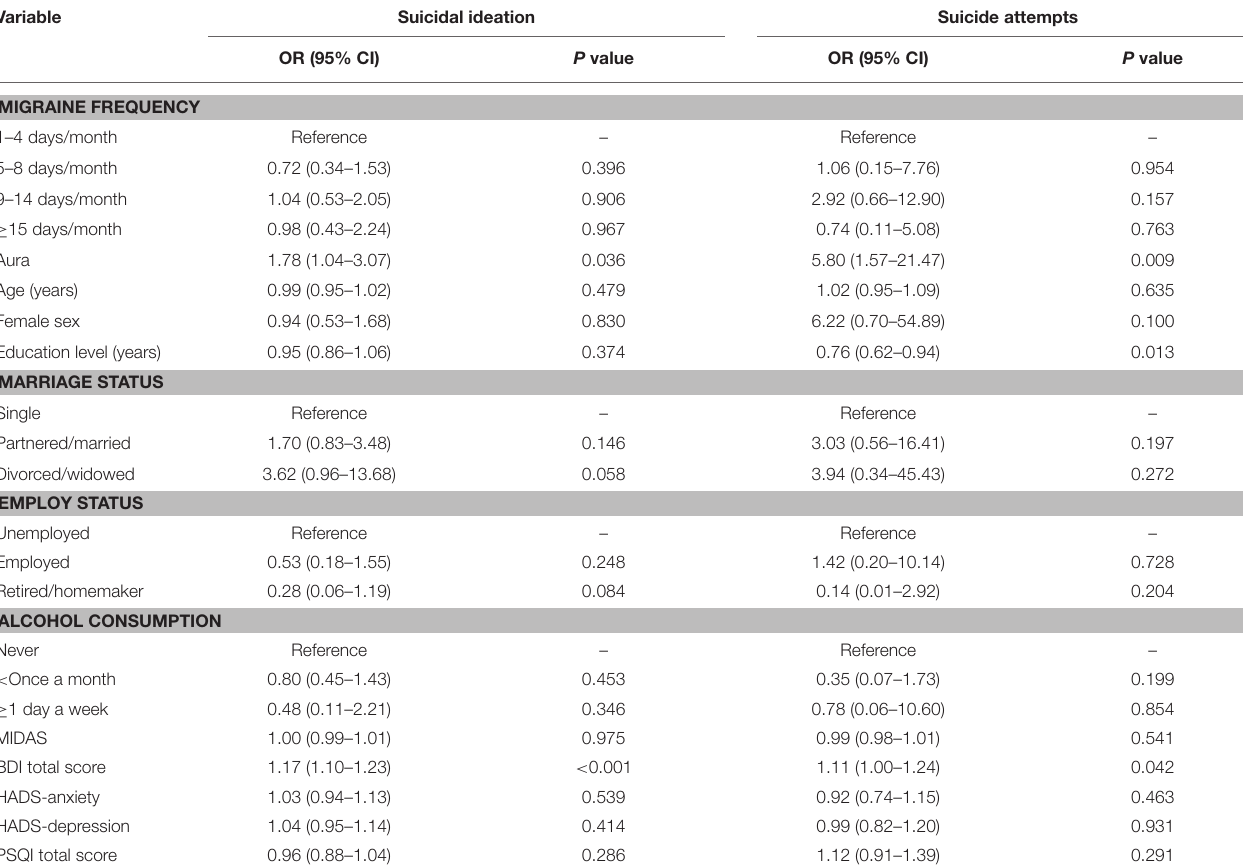
TABLE 3 | Multivariable logistic regression analysis of factors associated with suicidal ideation and suicide attempts in patients with